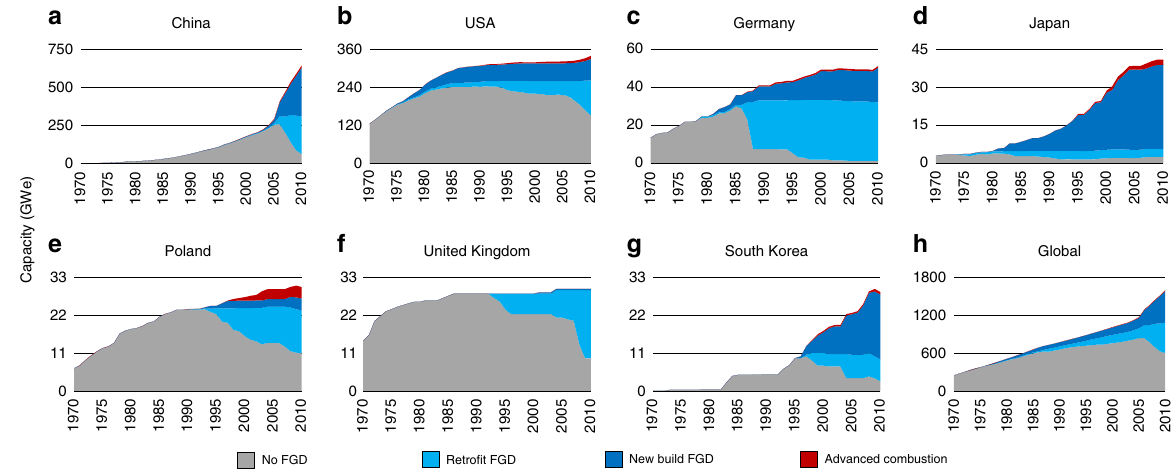
Fig. 1 Diffusion of sulfur control in the coal power sector of selected countries and globally. a – g show capacities for the largest national coal power sectors with signi fi cant uptake of FGD. h shows global coal power capacities. Electric capacity (GWe) of coal power units without FGD (grey), with retro fi t FGD (light blue), new build FGD (dark blue), or advanced combustion technology (red). The scales for the vertical axes vary by panel. Source data are provided as a Source Data fi